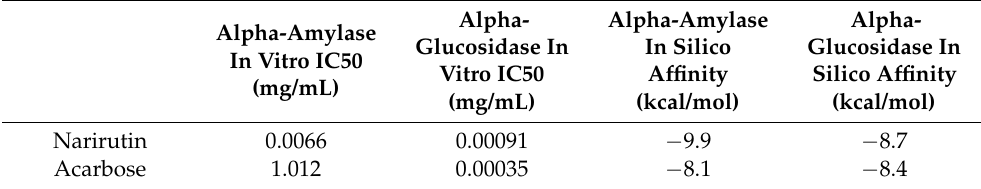
Figure 10. Alpha-glucosidase inhibitory effect results. Values are expressed as mean ± SD ( n = 3). As can be seen from Table 2, the results of the in vitro testing correlate perfectly with those obtained in silico. The difference in the affinity score of narirutin and acarbose against alpha-amylase in silico ( − 9.9 and − 8.1 respectively) was also seen in the in vitro test (0.0066 and 1.012, respectively). Against alpha-glucosidase, almost similar results were obtained in both tests, confirming the accuracy of the performed analysis. Table 2. Summary of narirutin and acarbose in vitro and in silico activities against alpha-amylase and alpha-glucosidase.